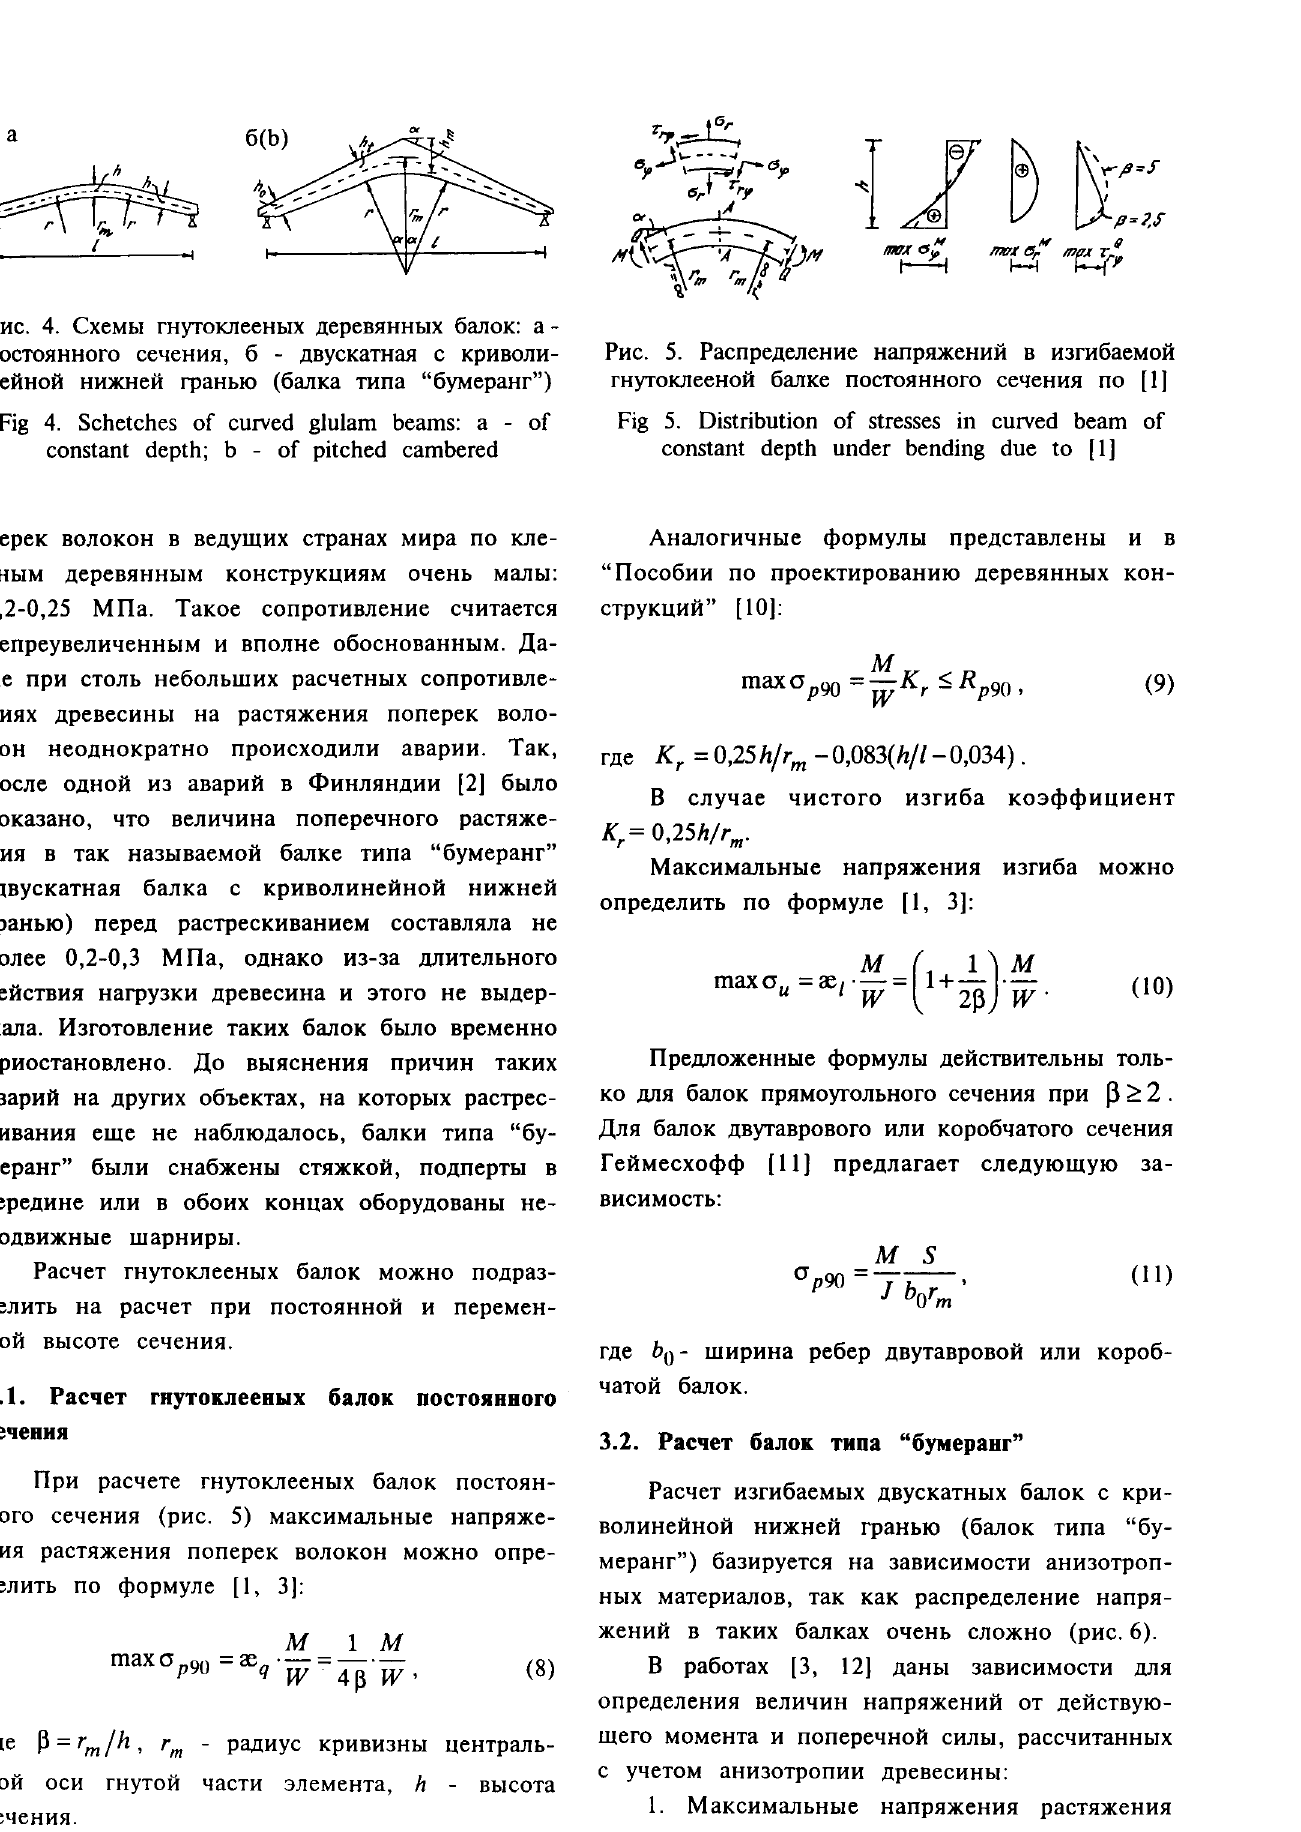
P11c. 5. Pacnpe.[(eJieHHe HanpH)I(eHHti B 113m6aeMoi1 rHyroKJieeHoii 6anKe nocTORHHoro ce'!eHI1H no [I] Fig 5. Distribution of stresses in curved beam of constant depth under bending due to [